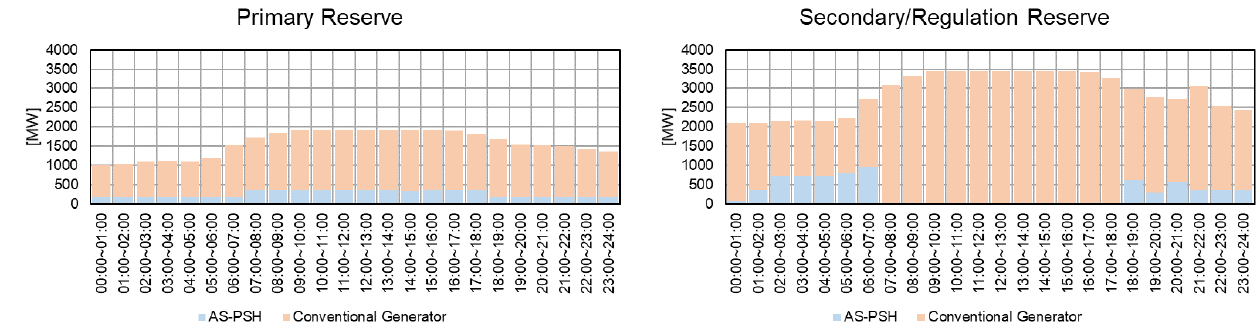
Figure 15. Reserves of AS-PSHs and conventional generators in Scenario D.